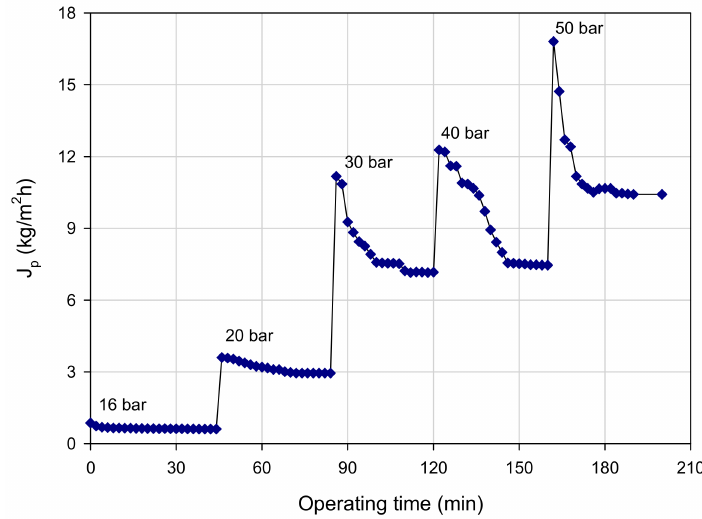
Figure 4. RO of pre-treated FGD wastewaters with SWC-2540 membrane. Permeate flux as function of transmembrane pressure (TMP) (T, 25 ◦ C; Q f , 240